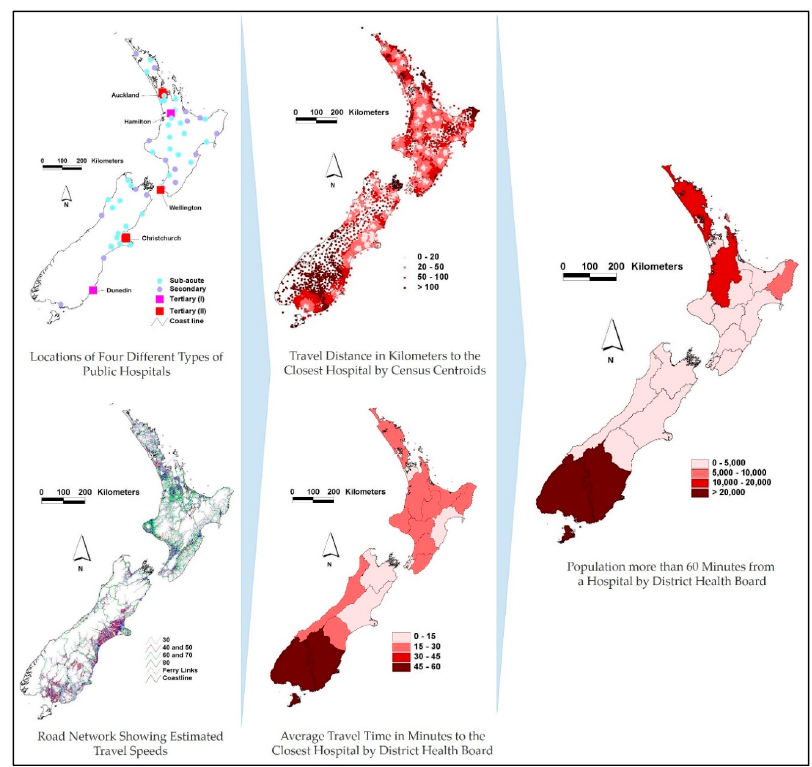
Figure 9. Modeling population access to New Zealand public hospitals. (Source: [56]).